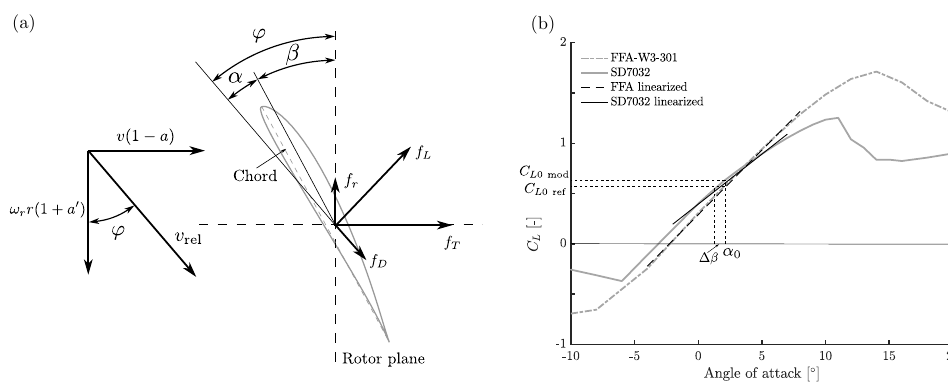
Figure A1. Aerodynamic model used for blade design. ( a ) Blade element for the generic blade section ( a and a (cid:48) are the axial and tangential induction coefficients, ω r is rotor speed, and r is the radial position of the blade element). ( b ) Lift coefficient of the FFA-W3-301 airfoil (DTU 10 MW), and of the SD7032 (scale model), with notation used in blade design